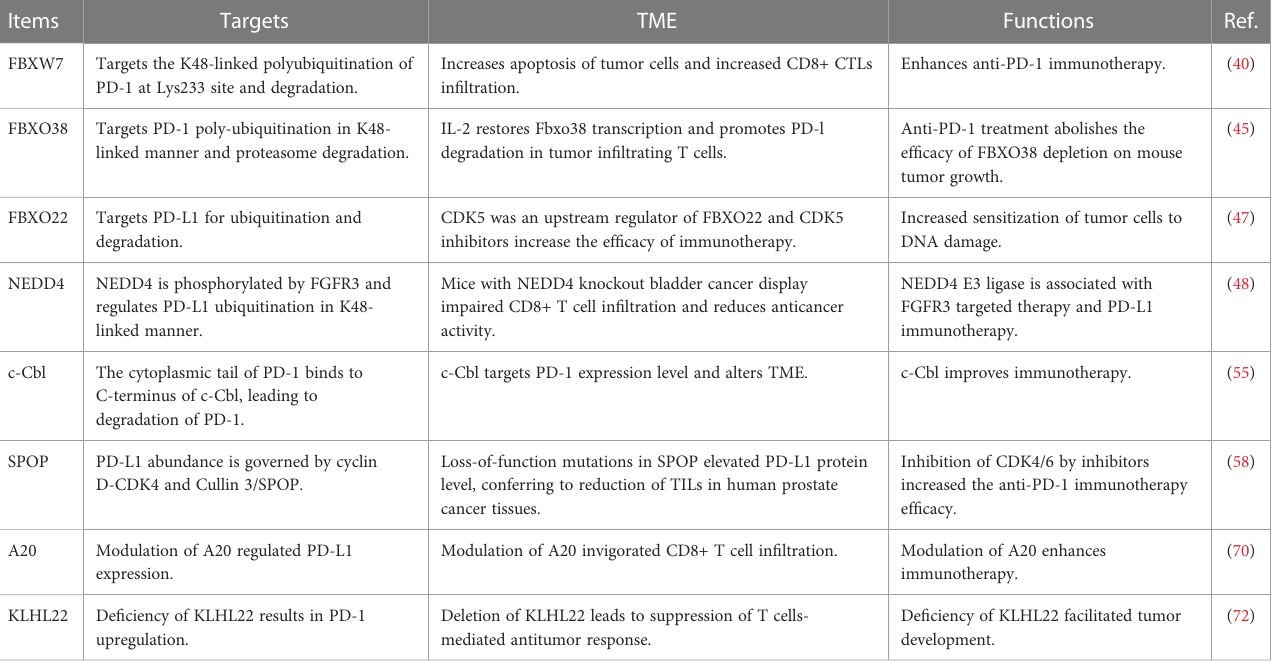
Enhances anti-PD-1 immunotherapy.